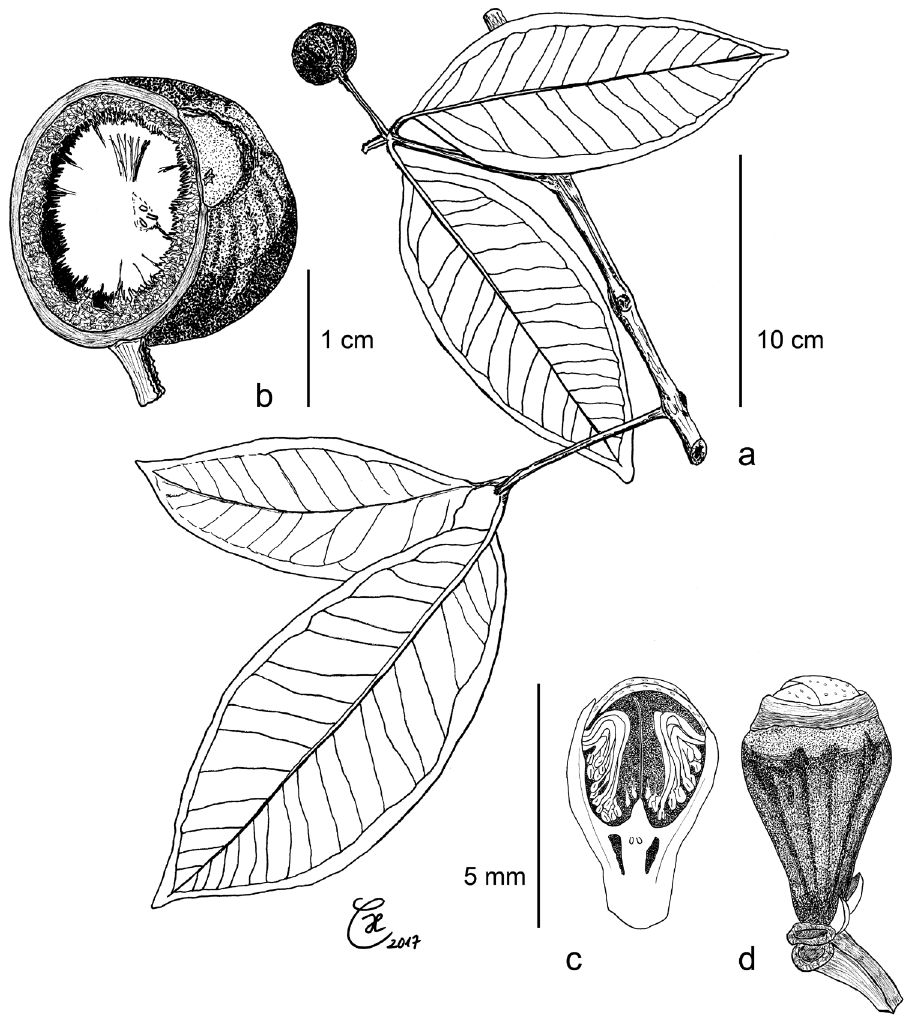
Figure 5. Syzygium devogelii : a leafy twig with fruit b longitudinal section of ripe fruit with inner, flat side of cotyledon and echinate outer surface c flower bud, longitudinal section d flower bud, exterior view. a–b holotype de Vogel 5293 c–d Culmsee 1564